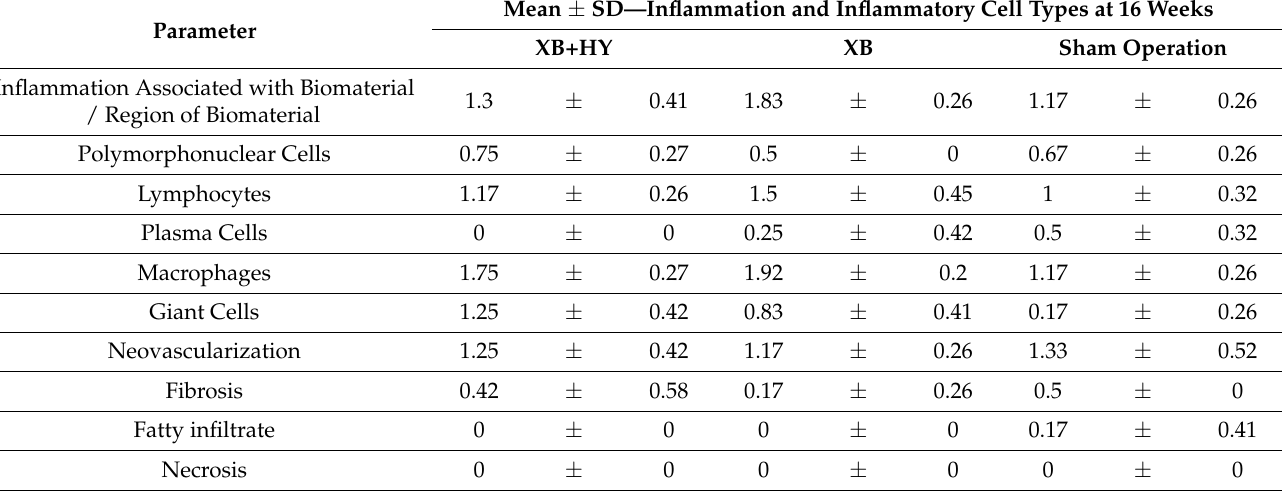
Table 3. Results of the scoring evaluation at 16 weeks post implantationem.